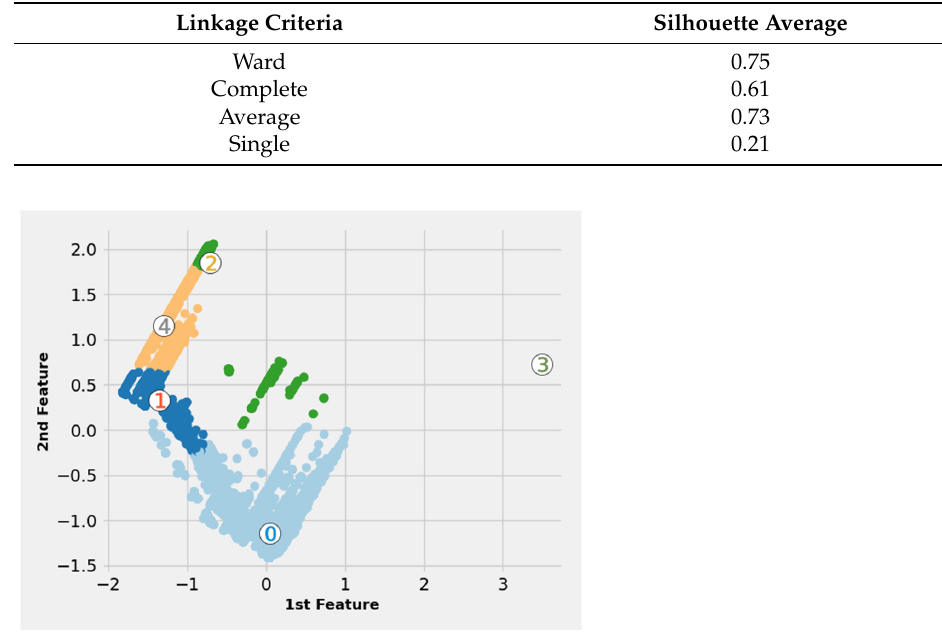
using ward linkage. ward linkage.